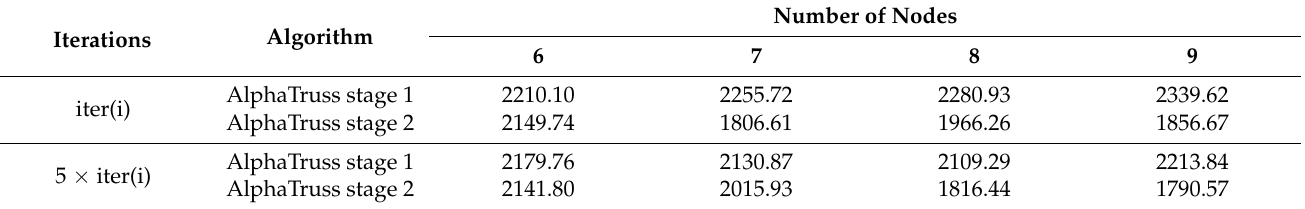
Table 13. Minimum weights (kg) with different number of nodes and number of iterations iter(i).